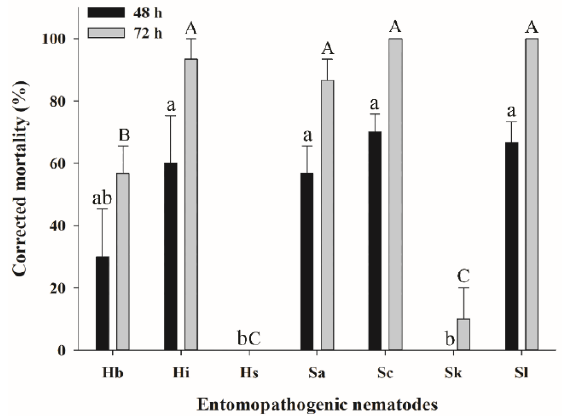
Figure 2. Corrected mortality of Spodoptera frugiperda in a soil column assay. A sixth-instar larva ( n = 1 per glass cylinder) of S. frugiperda was treated with entomopathogenic nematodes (EPNs) ( n = 600 infective juveniles) and mortality was determined 48 and 72 h after treatment. EPNs: Heterorhabditis bacteriophora (Hb), H. indica (Hi), Heterorhabditis sp. (Hs), Steinernema arenarium (Sa), Steinernema carpocapsae (Sc), Steinernema kushidai (Sk), and Steinernema longicaudum (Sl). The same small and capital letters above a bar indicate that there was no significant difference in mortality between EPNs at 48 and 72 h, respectively ( p > 0.05, Tukey’s test).